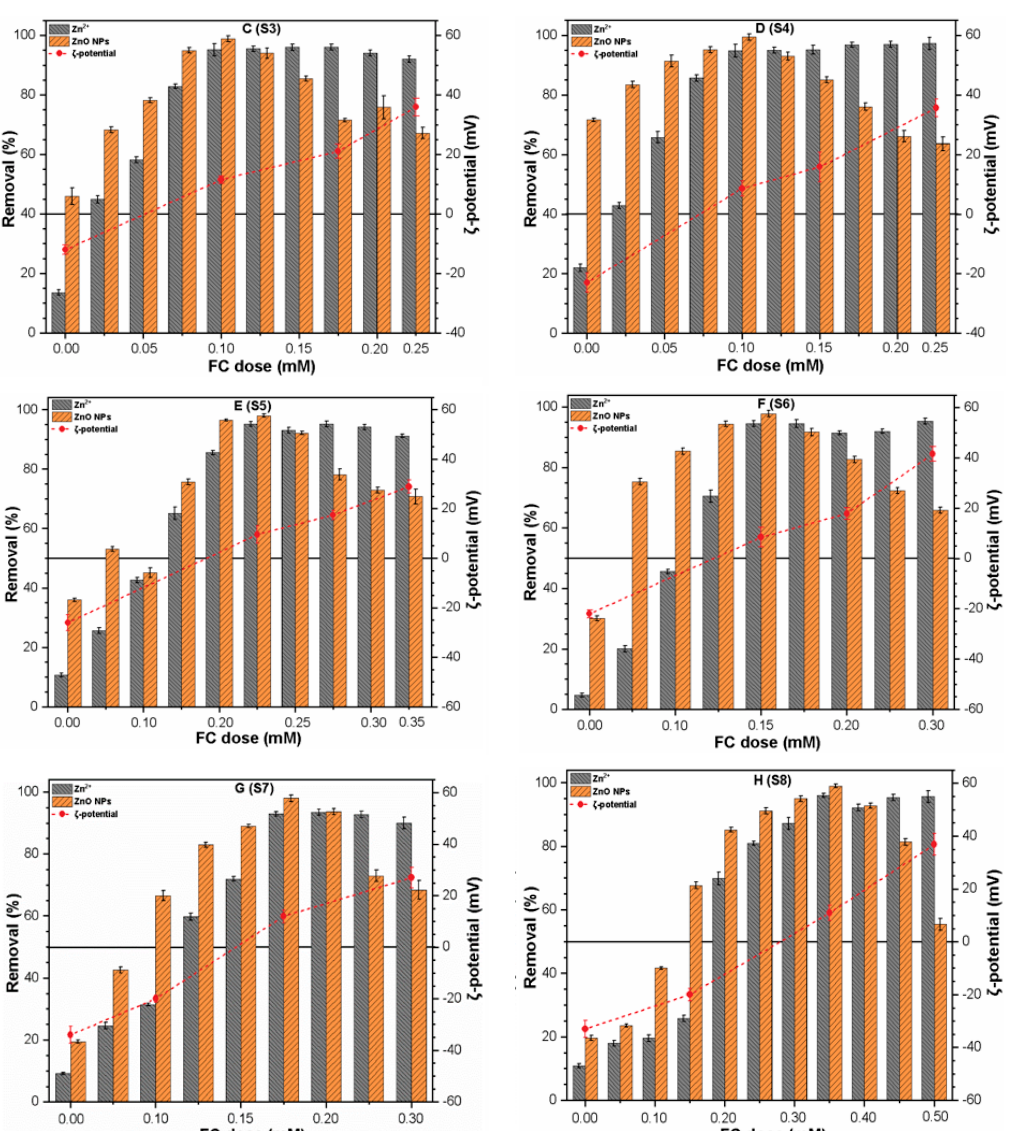
Figure 6. Removal of ZnO NPs and Zn 2+ from synthetics waters (S1–S8) as a function of coagulant dose with corresponding ζ -potential.